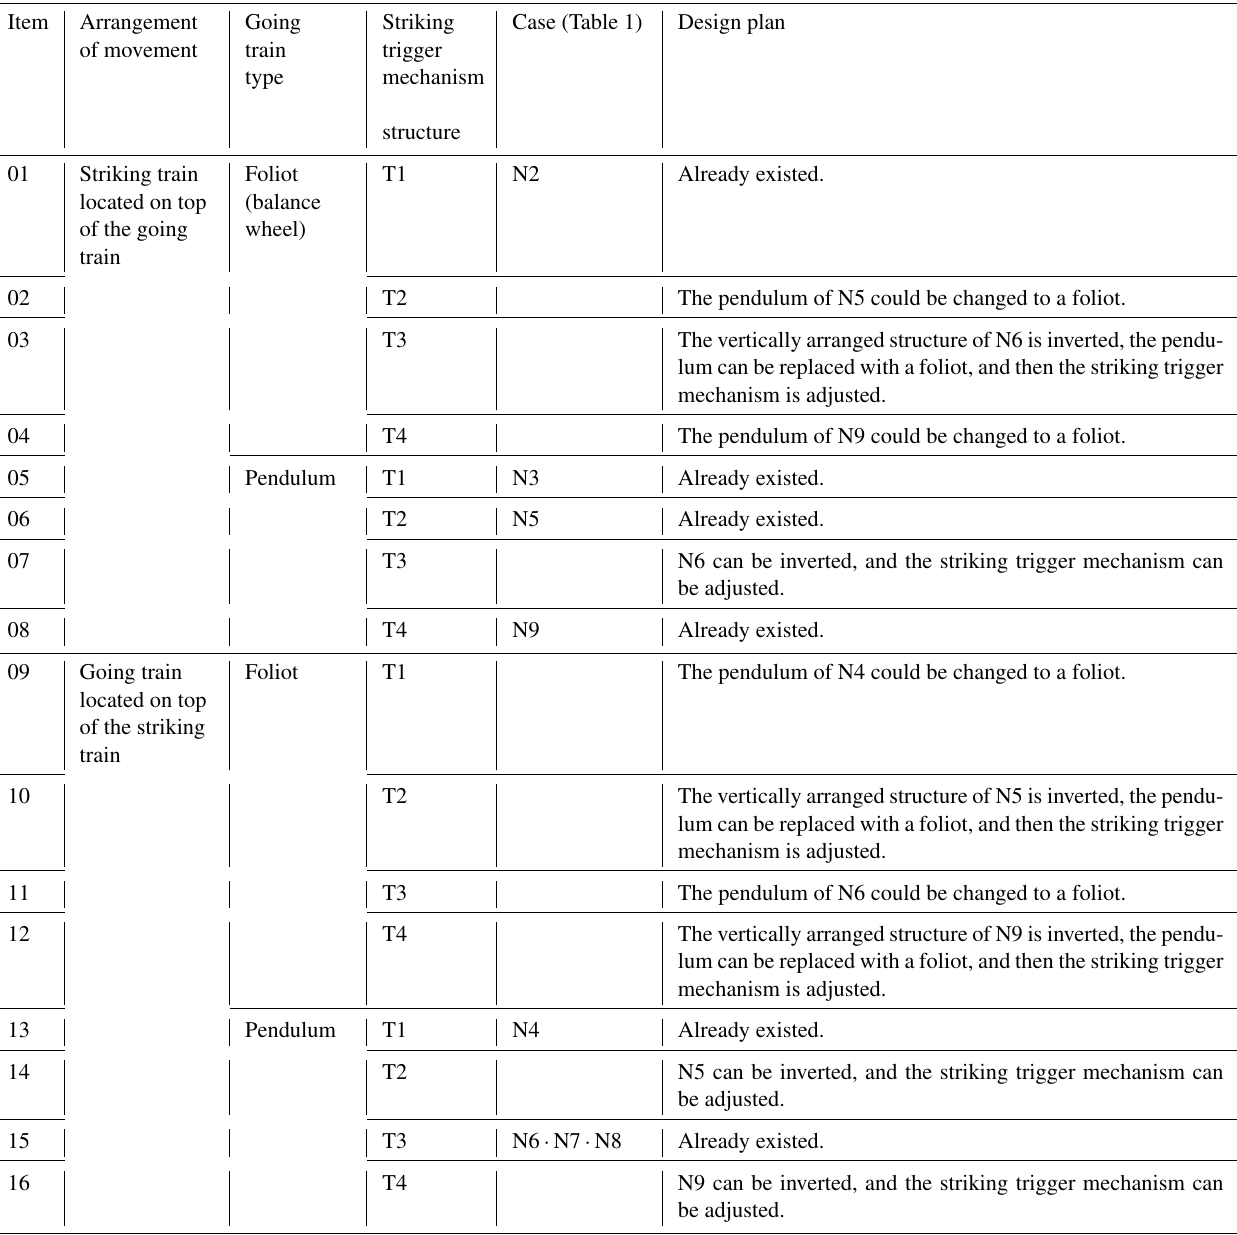
Table 6. Restoration of mechanism configurations based on the technology evolution of vertically arranged mechanical turret clocks. Case (Table 1) Design